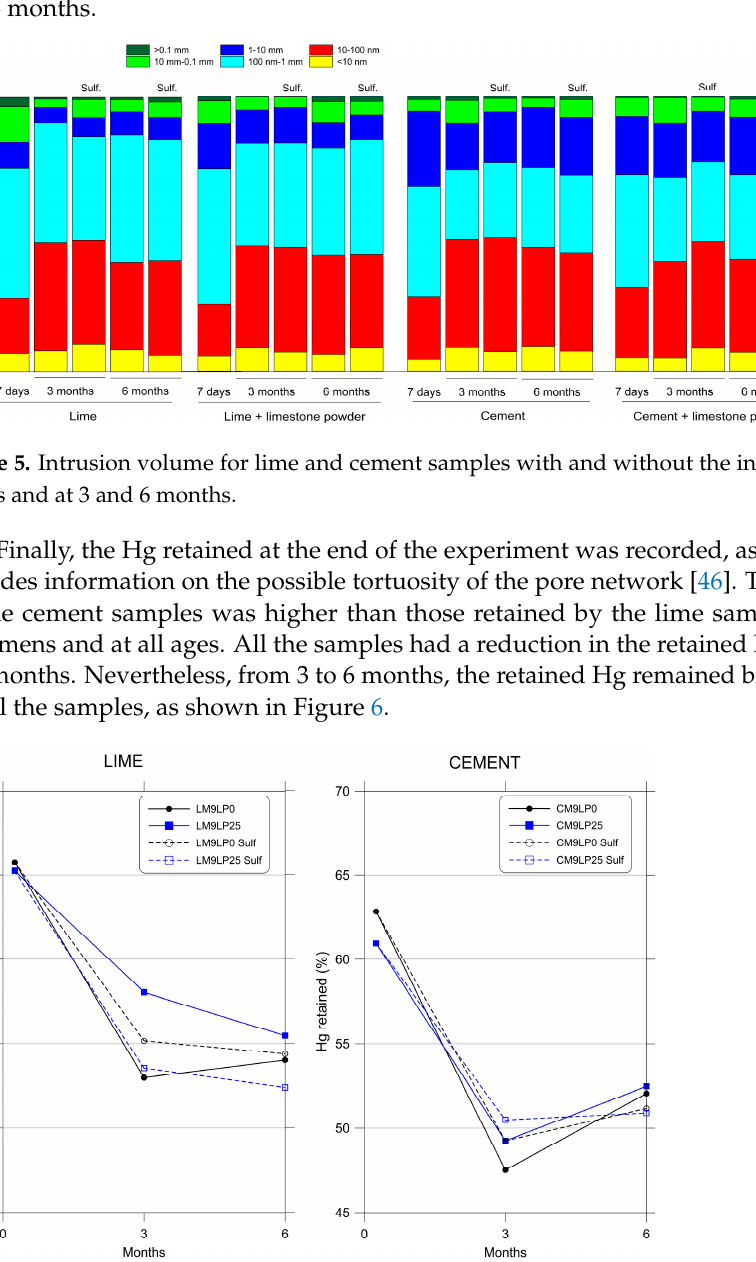
Figure 4. Total porosity of the lime and cement samples with and without the industrial waste at 7 days and at 3 and 6 months.